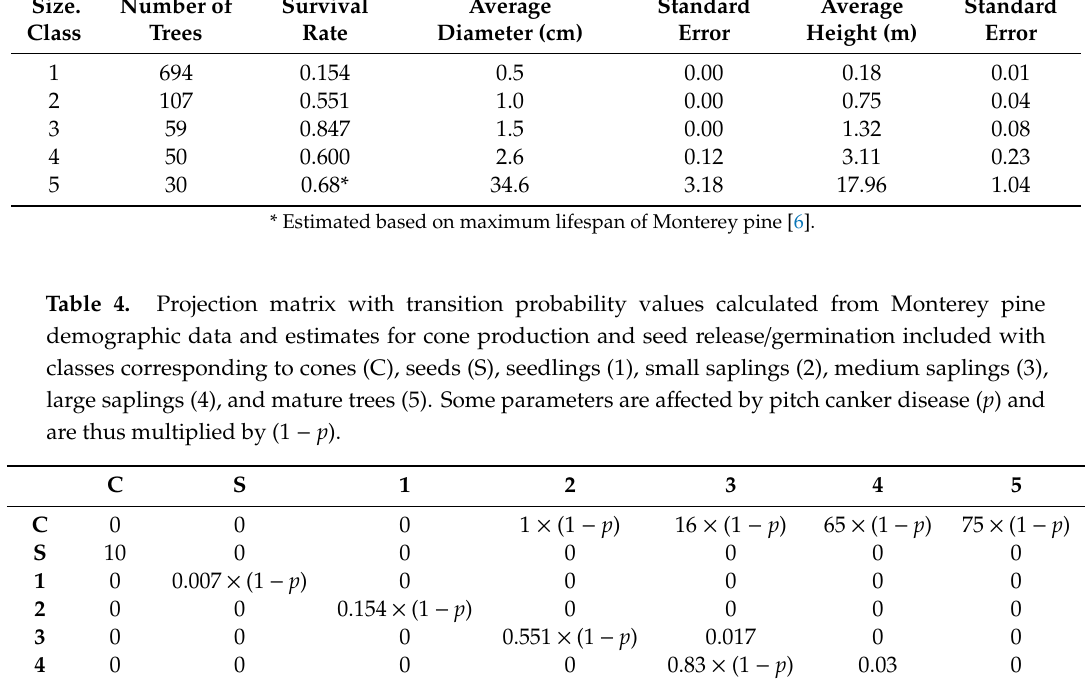
Table 3. Summary of 2011 Monterey pine forest demographic study where survival rates are calculated as the proportion of the next largest size class to the current one; data were collected from seven unmanaged plots in a native Pinus radiata forest on the Monterey peninsula with 5 m radius. Size.